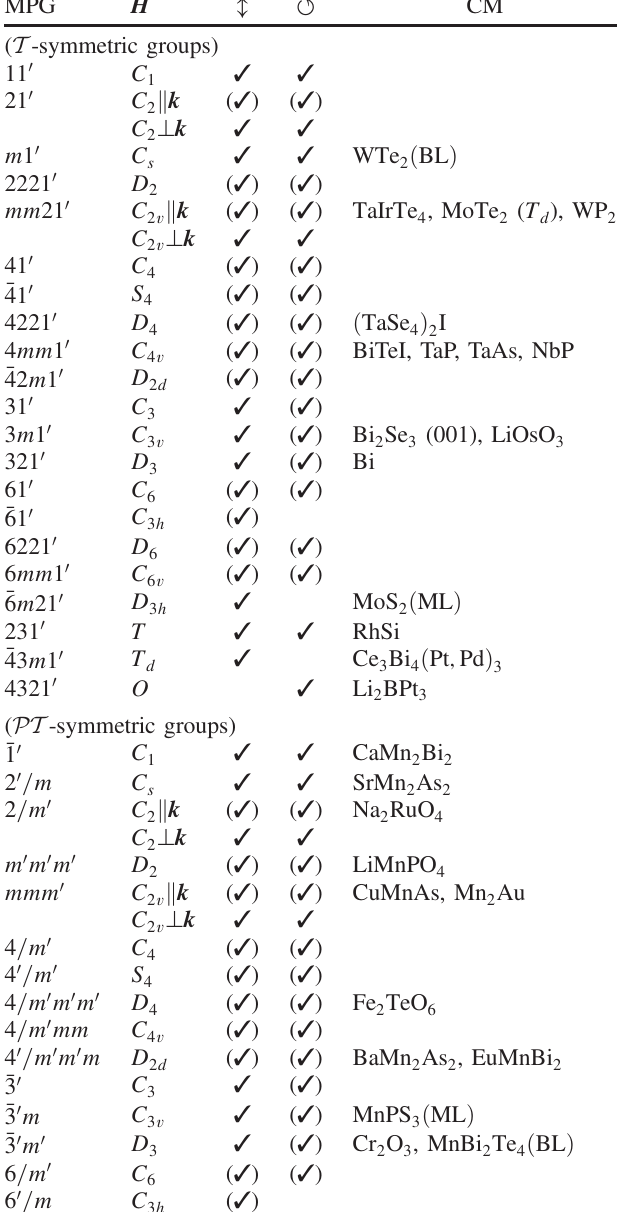
TABLE IV. List of the photocurrent responses allowed in the T -symmetric point groups (gray group) and PT -symmetric BW point groups. MPG denotes the magnetic point group, and H is the maximal unitary subgroup of MPG. The symbols ↕ and ↺ denote photocurrents induced by linearly polarized and circularly polarized light, respectively. The allowed response is indicated by ✓ . The low CM shows candidate materials, where (ML) or (BL) means monolayer or bilayer. As for the point groups, except for the cubic systems, some of the symbols ✓ are enclosed in parentheses to indicate that the corresponding responses are not allowed in two-dimensional systems. Classification of the point groups with H ¼ C 2 ; C 2 is further divided according to the v relation between the incident direction of light ( k ) and